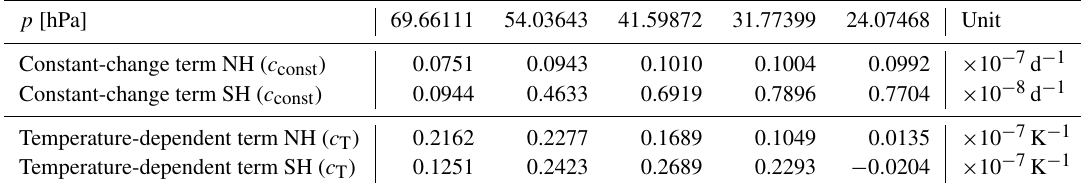
Table 2. Fit coefficients (used in ECHAM, ICON-NWP and AFES).